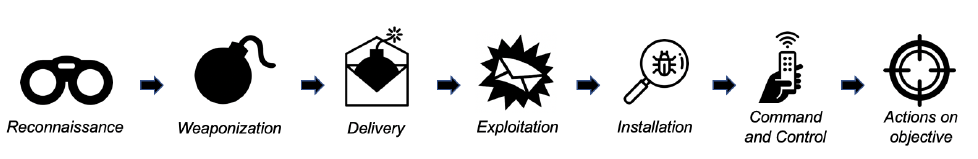
Figure 1. Cyber Kill Chain ® as defined in